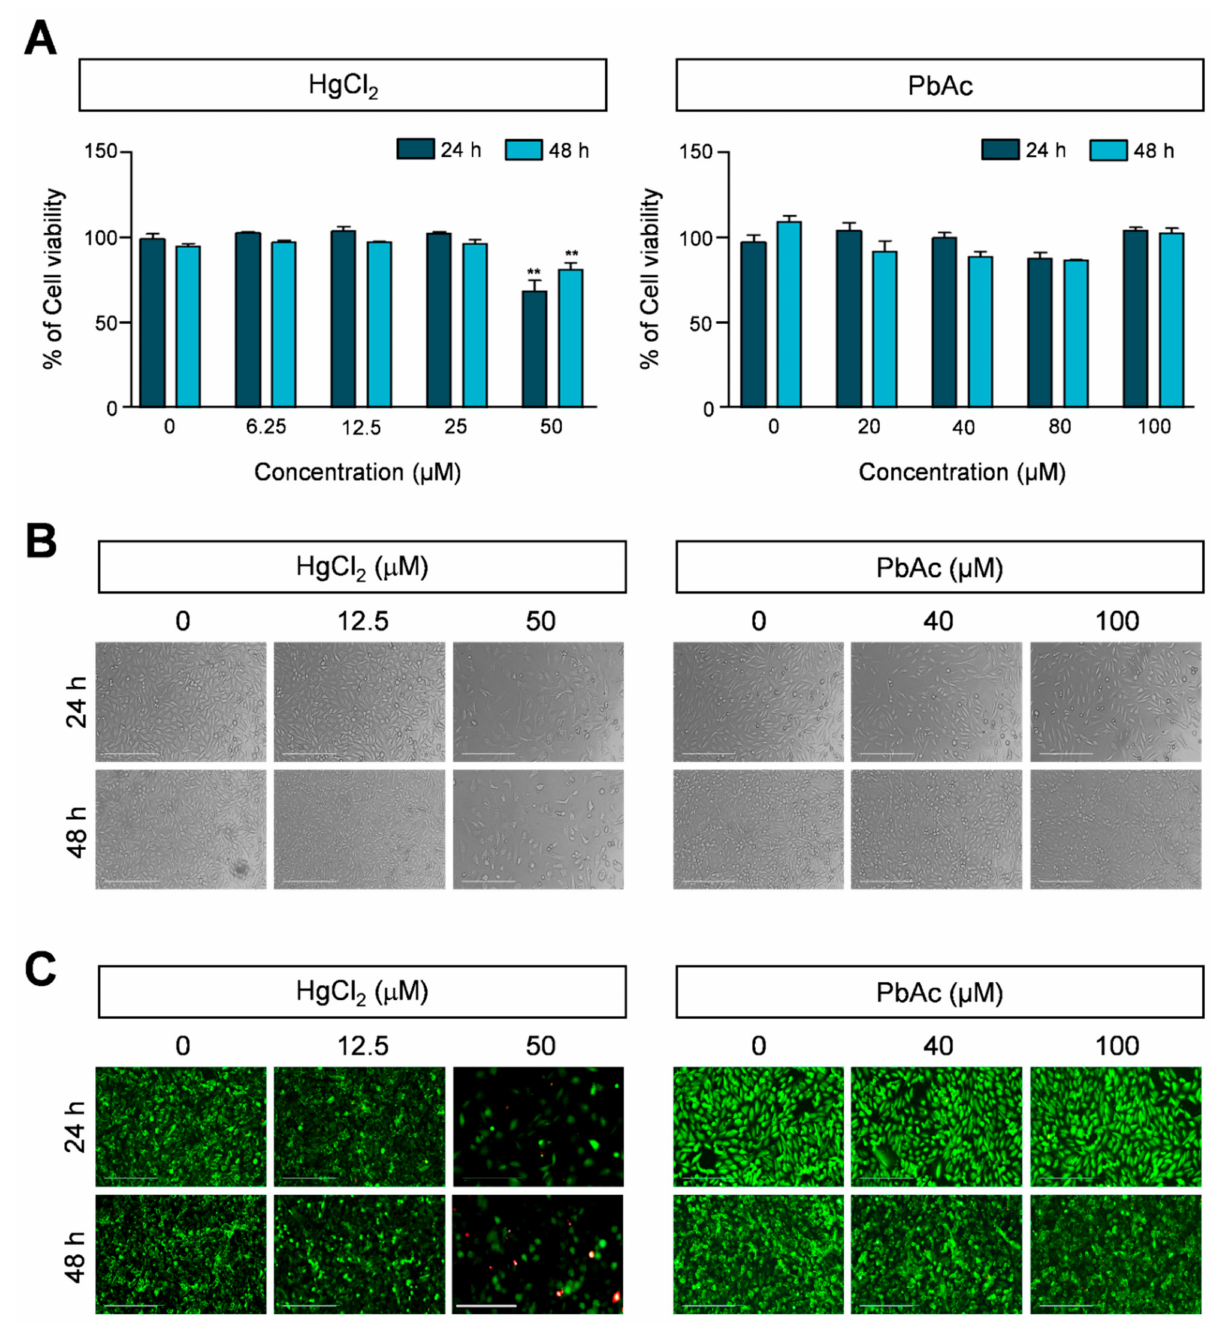
Figure 1. Effect of heavy metals on cell viability and morphology of MRC5 cells. ( A ) MRC5 cell viability was measured using the MTS assay. Cells were treated with 6.25–50 µ M of HgCl 2 and 20–100 µ M PbAc for 24 or 48 h. Data are represented as the percentage of the values obtained for the EtOH-treated cells used as the control. Error bars show mean ± SEM. p values obtained by Student’s t -test. ** p value < 0.05. ( B ) The morphology of MRC5 cells was observed by phase-contrast microscopy after treatment with indicated concentration of HgCl 2 and PbAc for 24 or 48 h. ( C ) MRC5 cells were stained with calcein-AM (green) and ethidium homodimer (red) by the live/dead assay. EtOH were used as the negative control. Images are representative of three independent experiments. Scale bars represent 200 µ